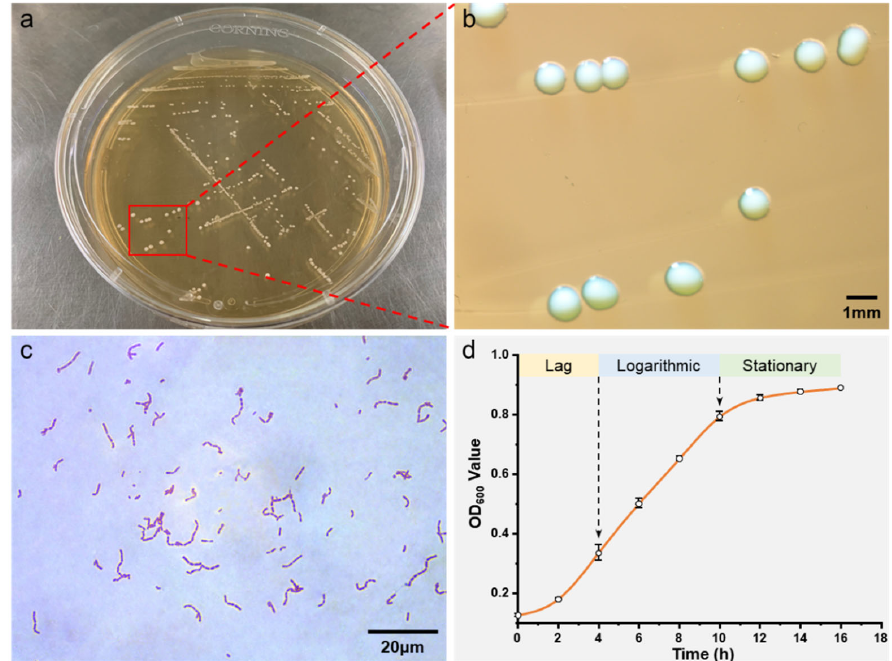
Figure 5. Morphological characteristics and growth curve of Lactobacillus rhamnosus. ( a ) The growth state of Lact. rhamnosus on MRS agar plate. ( b ) Observation of single colony under an optical microscope. ( c ) Bacterial morphology with Gram staining (×100 magnification). ( d ) Growth curve of Lact. rhamnosus .